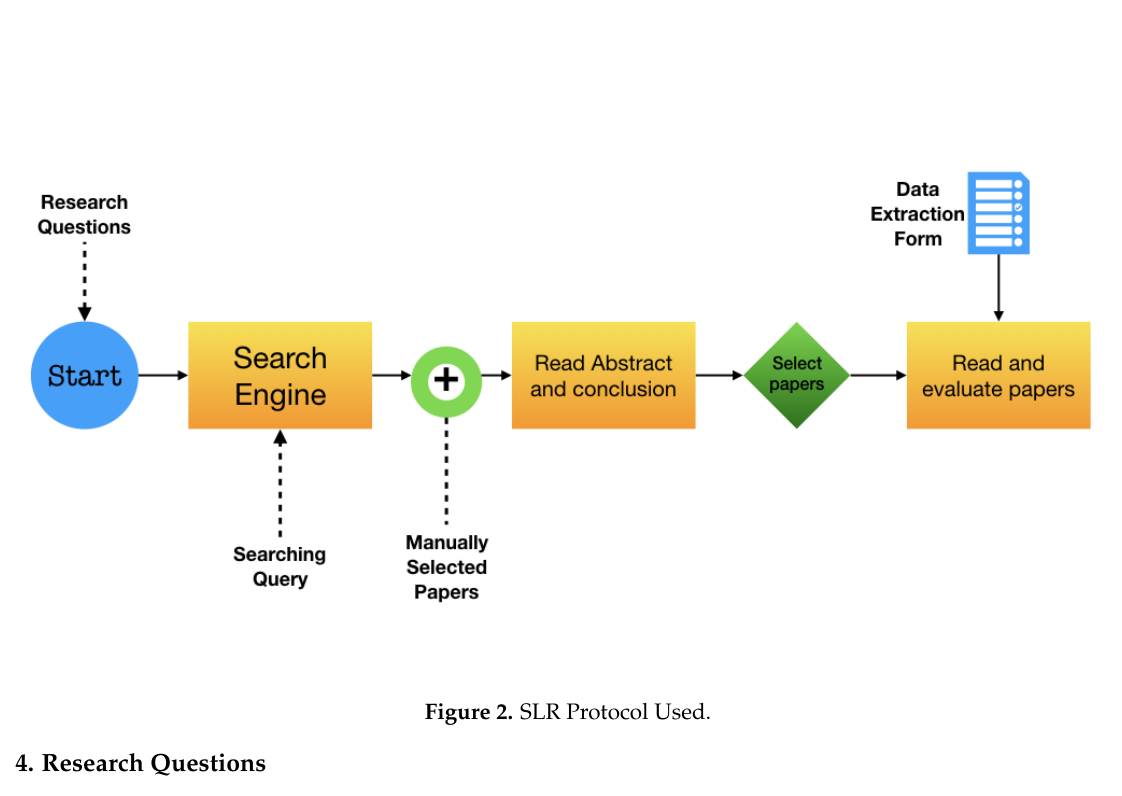
Figure 2. SLR Protocol